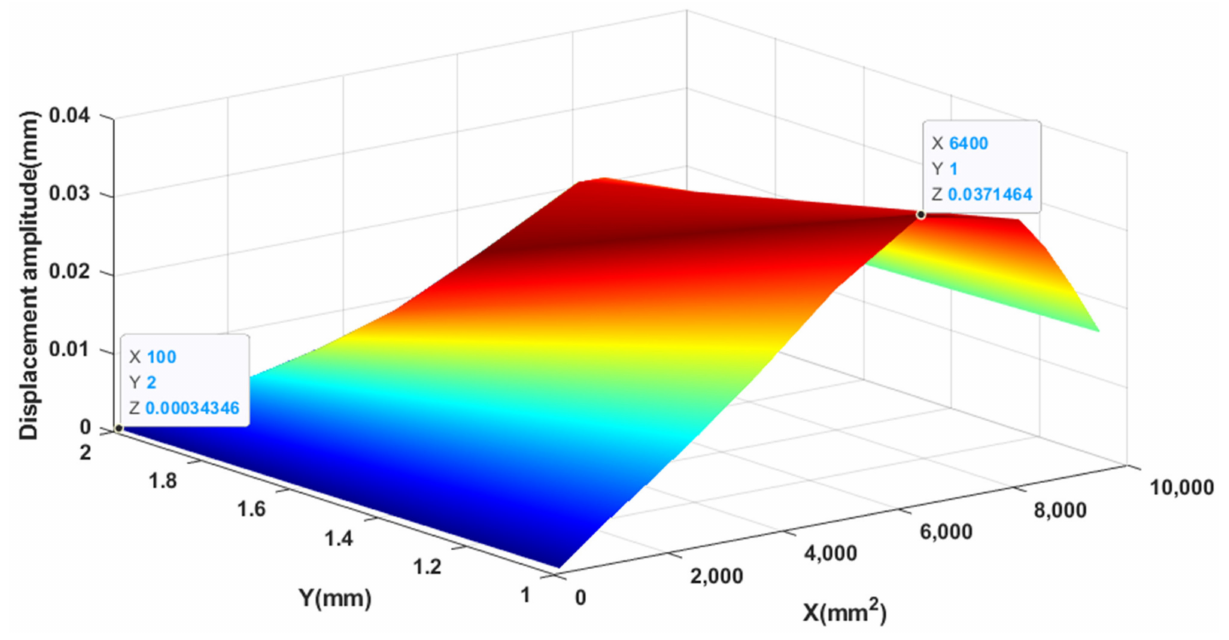
Figure 8. Displacement amplitude varies with area and thickness.